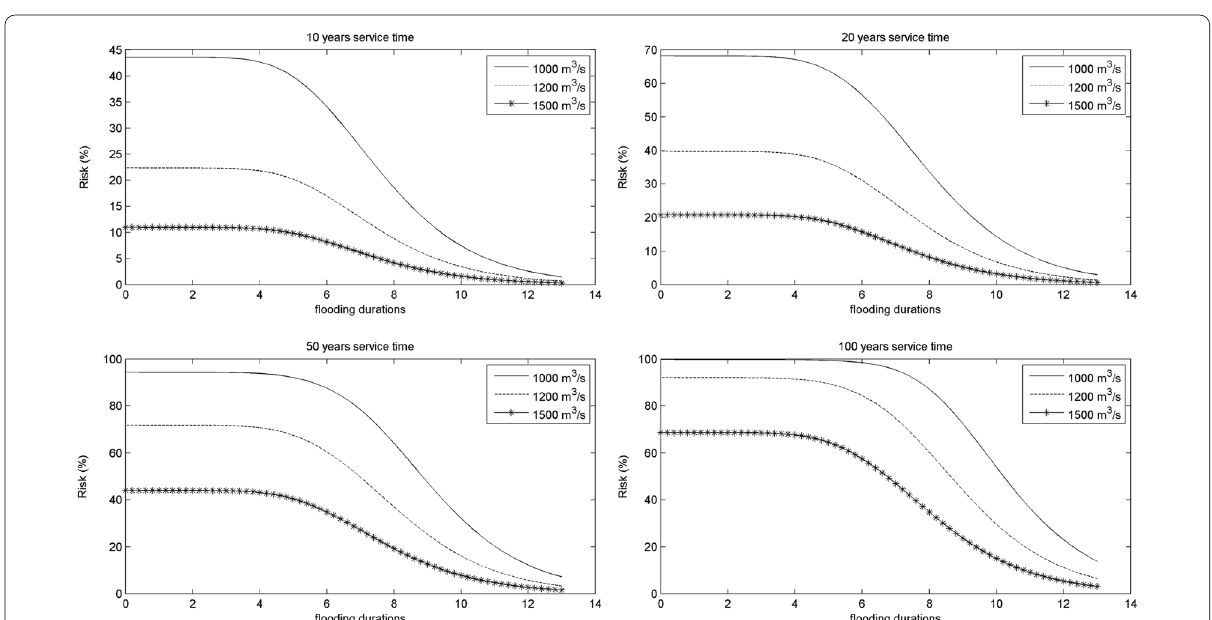
Fig. 11 Bivariate flooding risk under different flooding peak-duration scenarios